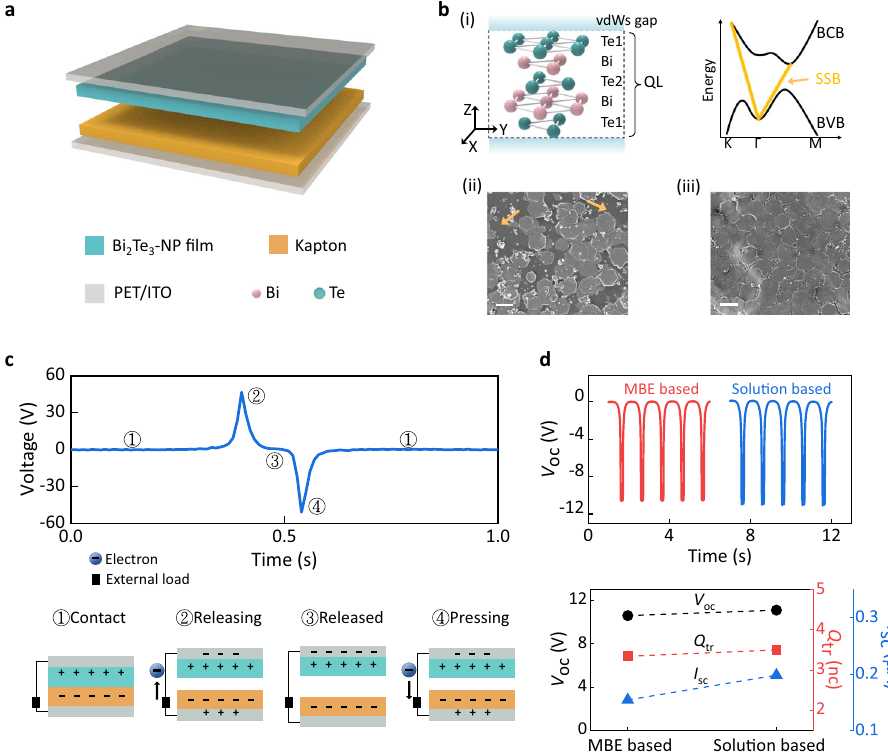
Fig. 2 The demonstration of the TI-TENG. a Structural schematic diagram of a TI-TENG based on Bi 2 Te 3 -NP fi lm. b Crystal structure (i) of the quintuple layer (QL) Bi 2 Te 3 (Te(1) – Bi – Te(2) – Bi – Te(1)) and a sketch of the band structure diagram with typical bulk bandgap (bulk conductive band/BCB, bulk valance band/BVB, black lines) and unique conductive surface state band (yellow line, SSB). The vdWs gap represents the van der Waals gap between each QL. SEM images of the TI fi lms with different coating doses of Bi 2 Te 3 NP colloid ((ii) 2 mL and (iii) 10 mL). The scale bars are 500 nm and the arrows highlight the discontinuity of Bi 2 Te 3 -NP fi lm with a lower coating dose. c Output voltage signal of solution-based TI-TENG (8 mL, 5 × 5 cm 2 ) in one cycle. The down panels show the working principle for several different stages. d Comparison plots of the output properties of TI-TENGs assembled with solution-based Bi 2 Te 3 -NP fi lm (8 mL, 0.5 cm 2 ) and MBE-based Bi 2 Te 3 fi lm, which reveal their slight differences. Source data are provided as a Source Data fi